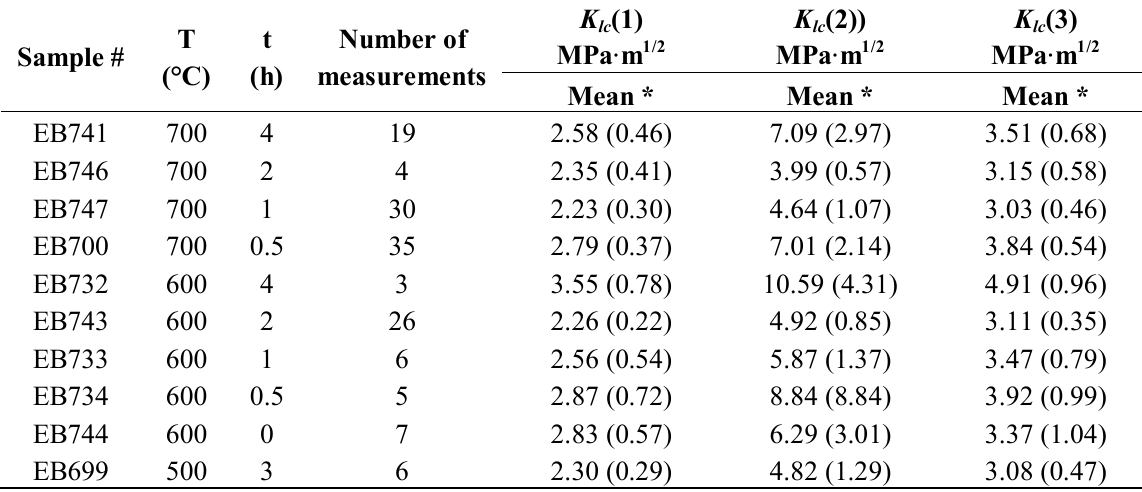
Table 5. Fracture toughness of Ti N samples annealed at 2 GPa. Here hardnesses and 3 4 crack lengths used are from microindentation indentation experiments. A constant Young’s modulus, E = 500 GPa, was assumed for these calculations. Models (1) and (2) assume Palmqvist cracks, and model (3) assumes halfpenny